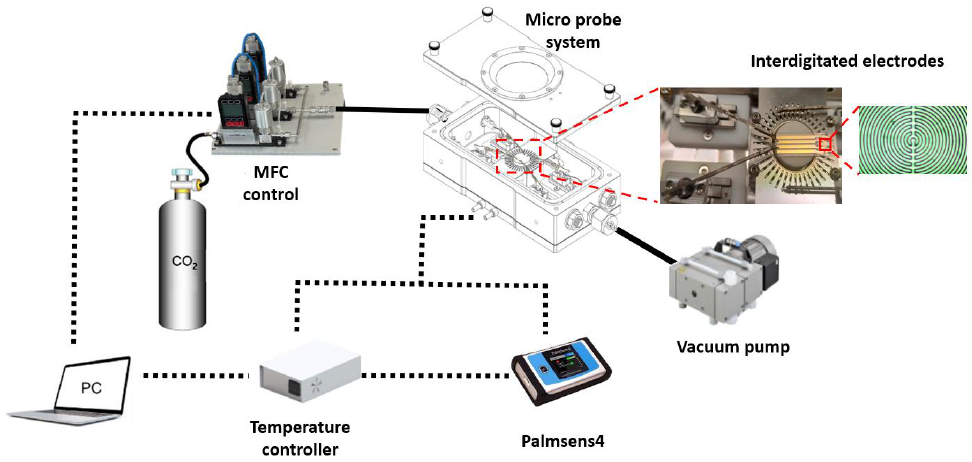
Figure 1. Sensing measurement set up used in this